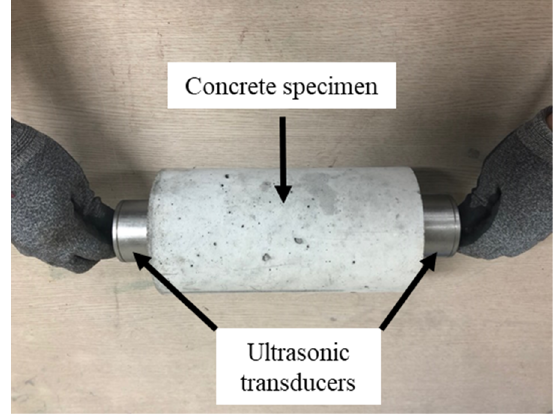
Figure 12. Measurement of ultrasonic velocity.